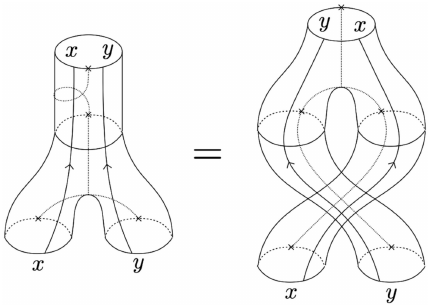
Figure 12 . The multiplication M is commutative up to isomorphism X xy .